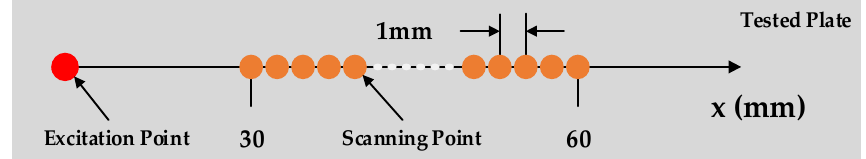
Figure 3. Schematic diagram of linear scanning of laser vibrometer.